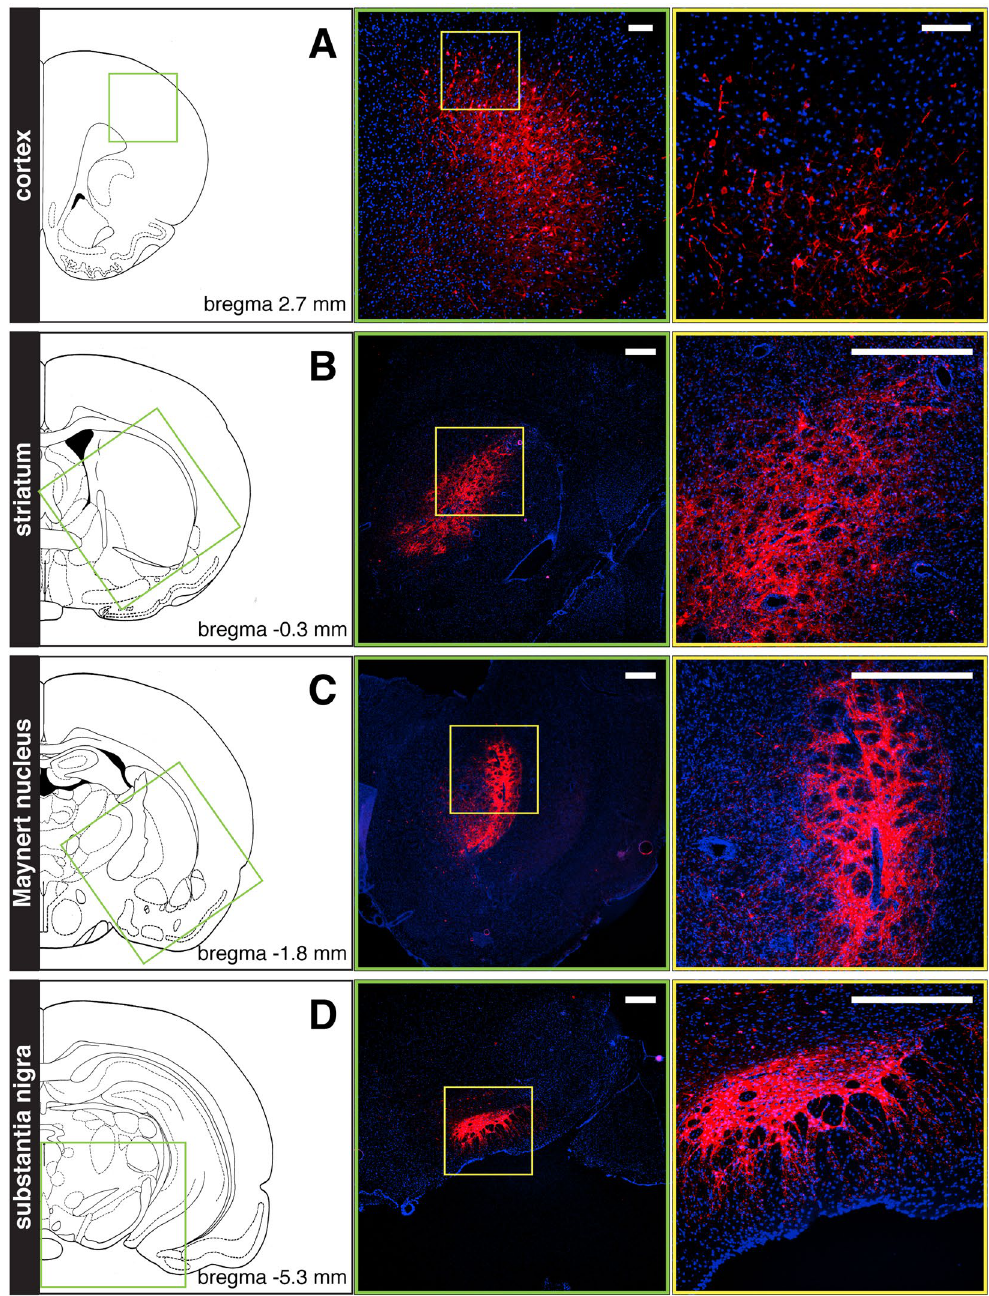
Figure 6. Transgene expression in different brain areas. Representative images (5 sections/animal, 4 animals/ group) taken from coronal sections prepared from animals killed 2 weeks after J Δ NI6 injection into the prefrontal cortex ( A ), striatum ( B ), Maynert nucleus ( C ) or substantia nigra ( D ). Native mCherry fluorescence in red; DAPI-stained nuclei in blue. Left panels are schematic drawings (adapted from Paxinos and Watson 22 with permission from Elsevier) of the brain structures at the level of vector injection; anteroposterior coordinates relative to bregma are indicated. Central panels are images of sections corresponding to the area framed in green in the corresponding left panel. Right panels are higher magnifications of the areas framed in yellow in the corresponding central panel. Horizontal bars in A = 100 μ m; horizontal bars in B – D = 500 μ